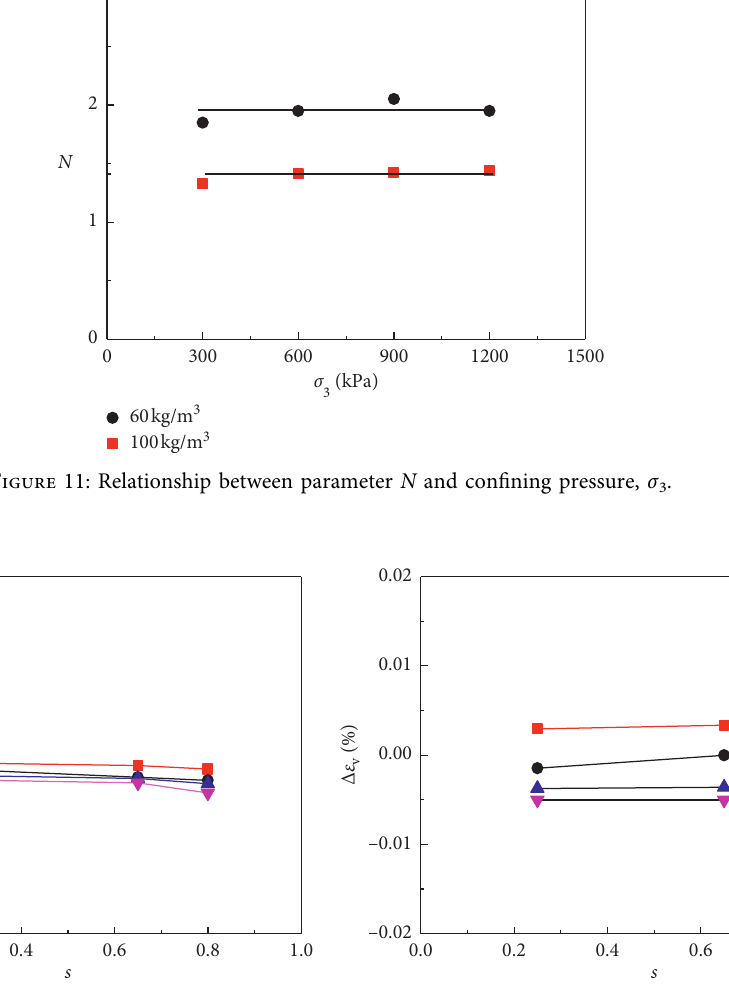
Figure 12: Relationship between volumetric increments during unloading and stress level, s , for different cementing agent contents. (a) 60 kg/m 3 . (b) 100kg/m 3